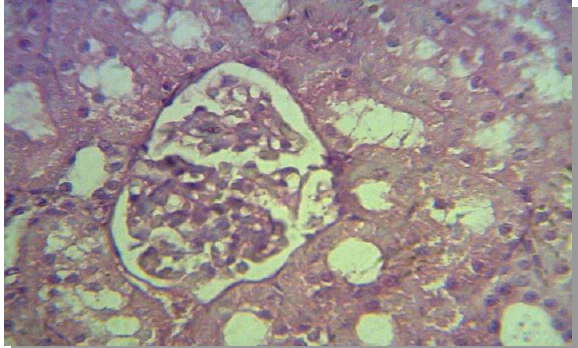
Fig.4: Histopathological section in the kidney of control group at 42 day post treated shows no clear lesions (H and E stain 40X)